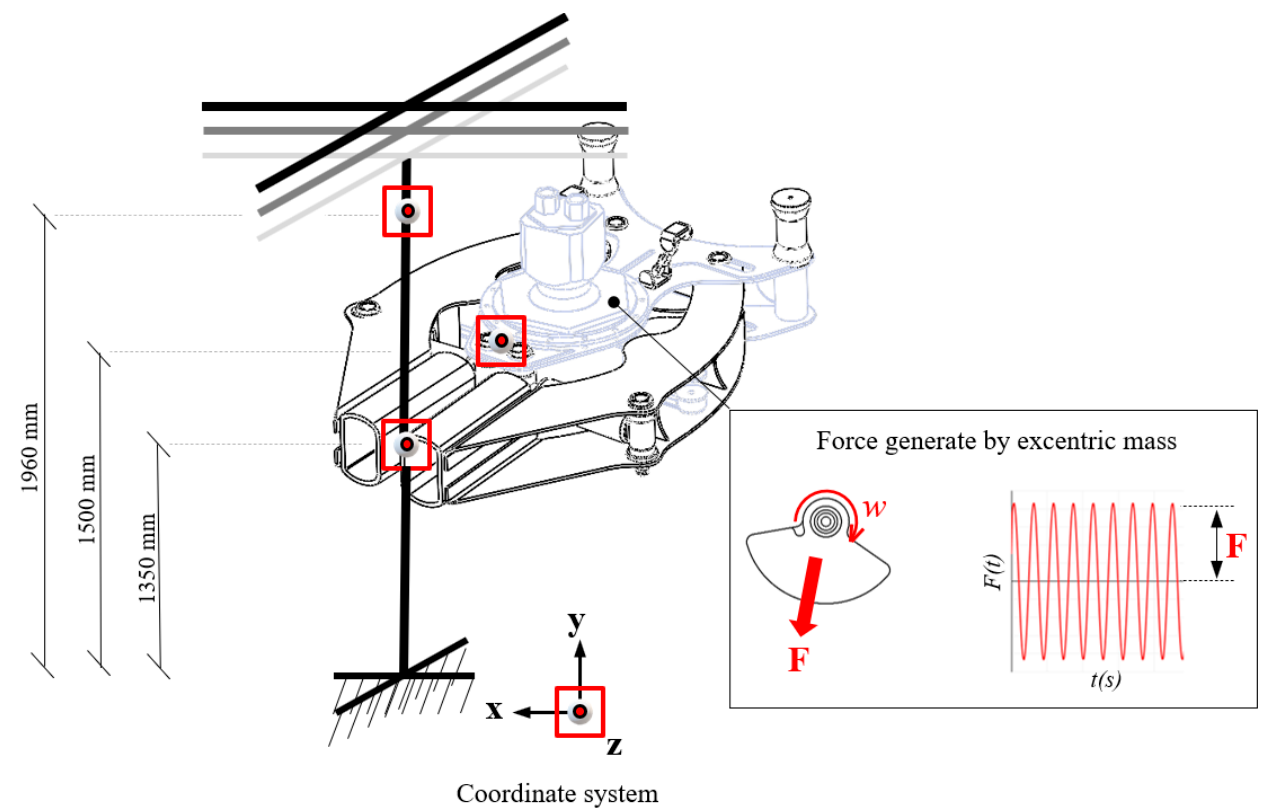
Figure 3. Position of the accelerometers on the test bench.